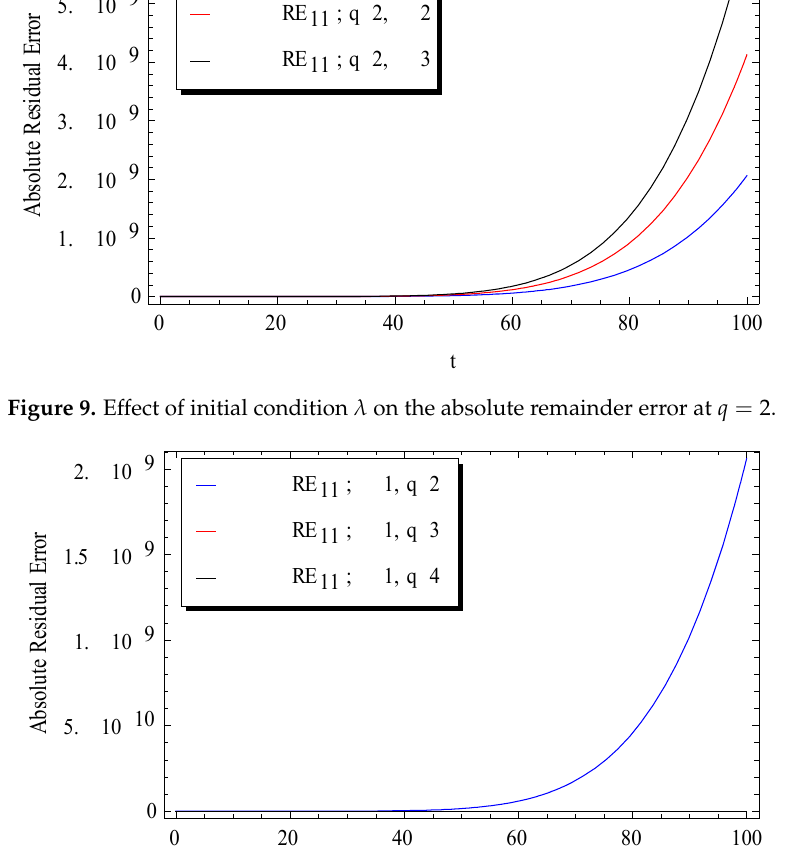
Table 1. Comparison of the present exact solution with the homotopy analysis transform method (HATM) and Daftarday-Gejji and Jafari solutions. t